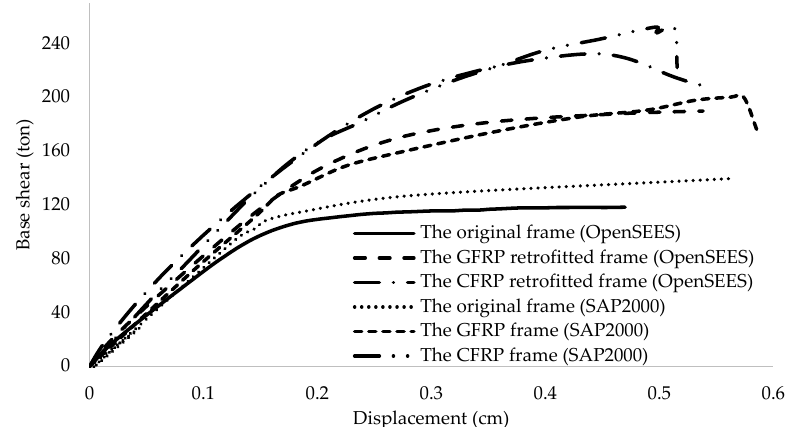
Figure 8. The results of the pushover analysis for original and flange ‐ bonded CFRP and GFRP frames.